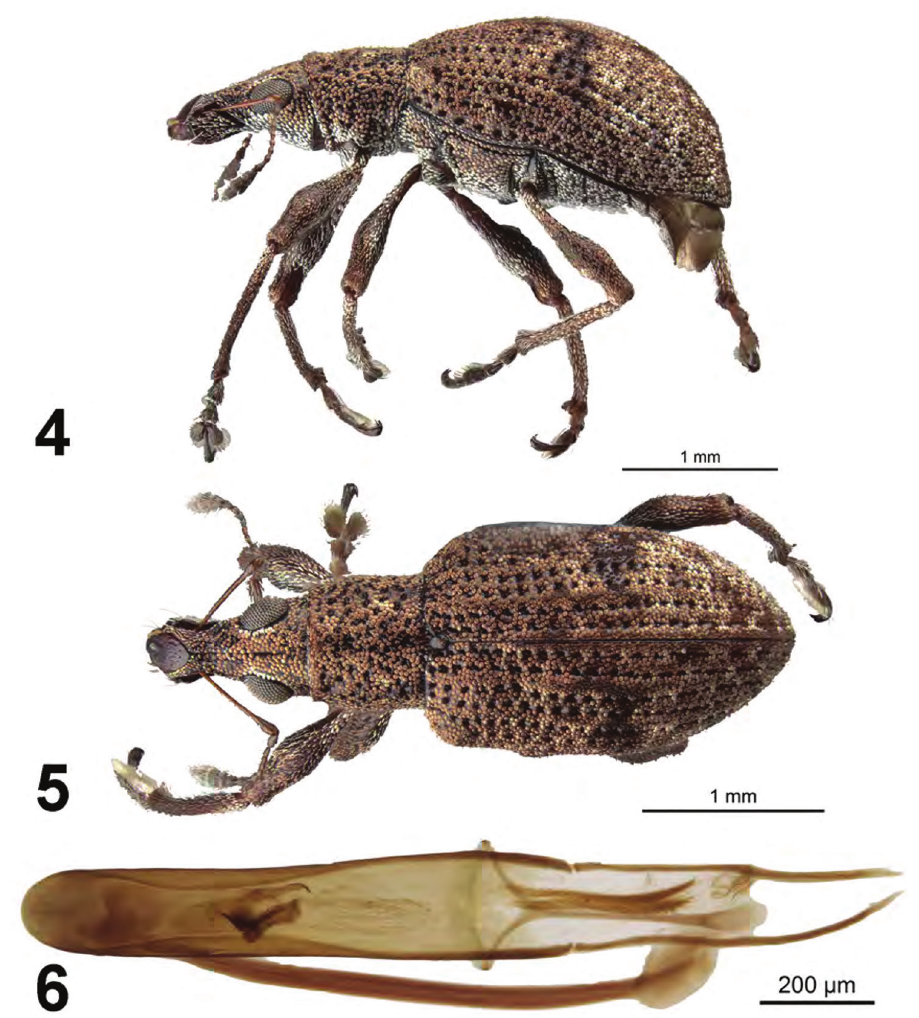
Figures 4–6. Apodrosus alternatus. 4 Lateral habitus, male 5 Dorsal habitus, male 6 Male aedeagus,